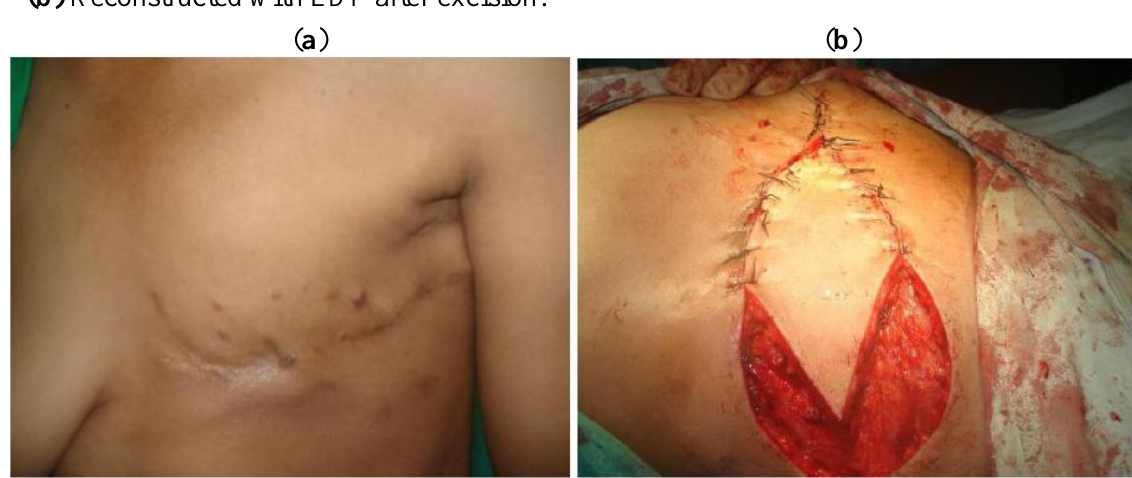
Figure 2. (a) female patient 45 years with recurrent skin nodules after MRM; (b) Reconstructed with LDF after